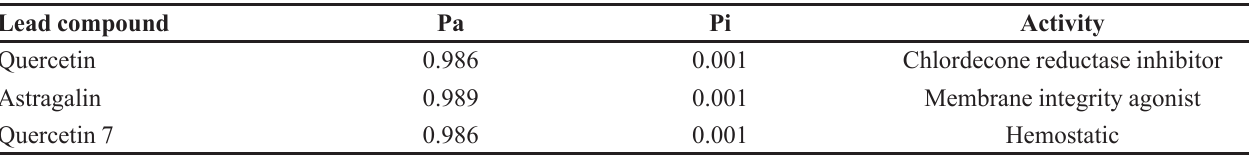
Pa: Probability of activity. Pi: Probability of inactivity.